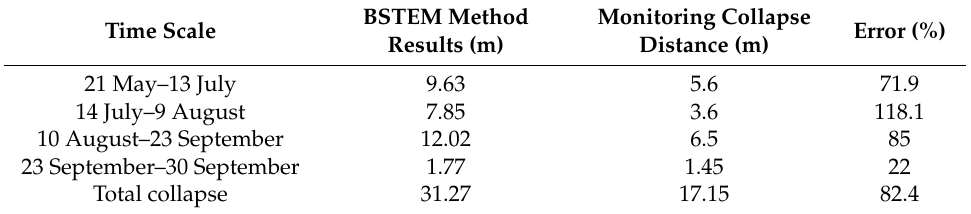
Table 15. BSTEM results, field measurements and errors for surveying Section